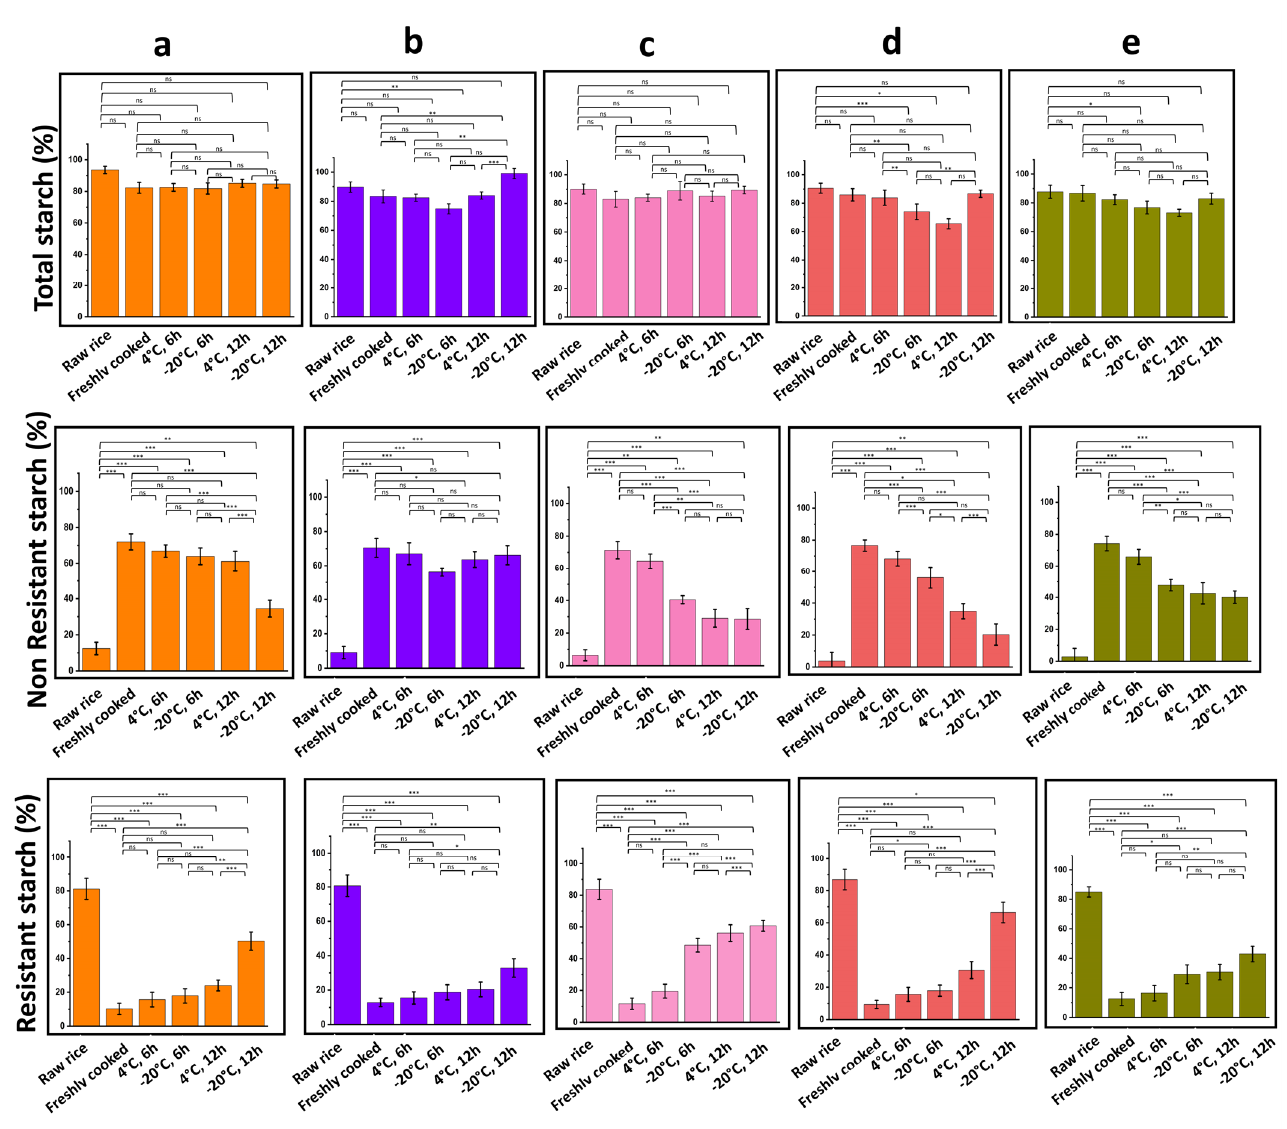
Figure 3. Total starch (TS%), non-resistant starch (NRS%), and resistant starch (RS%) with increasing time and decreasing temperature of storage: ( a ) Diasang lahi, ( b ) Khaju lahi, ( c ) Dhusuri bao, ( d ) Omkar, and ( e ) Bili rajamudi . (P>0.05 ns , P<0.05*, P<0.01**, P<0.001***)